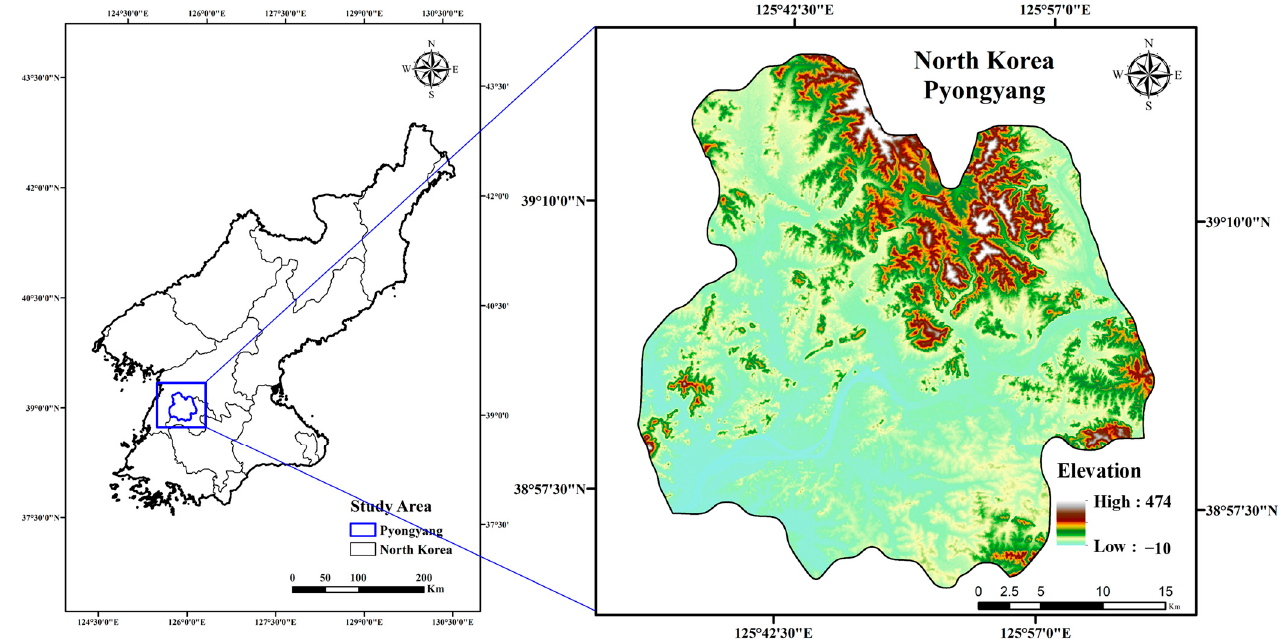
Figure 1. Study area: Pyongyang, North Korea (Democratic People’s Republic of Korea) with elevation.